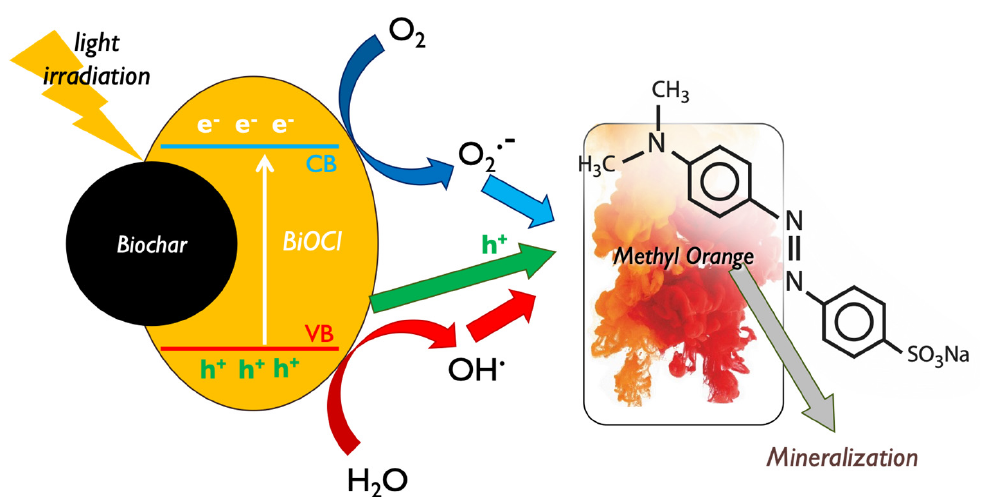
Figure 12. The involved active species during the photocatalytic methyl orange decomposition by bismuth oxychloride composite with lignin-derived biochar.